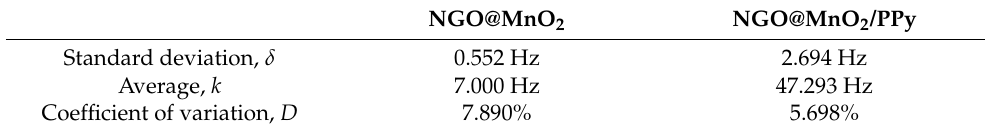
Table 2. The calculated values of δ , k , and D .